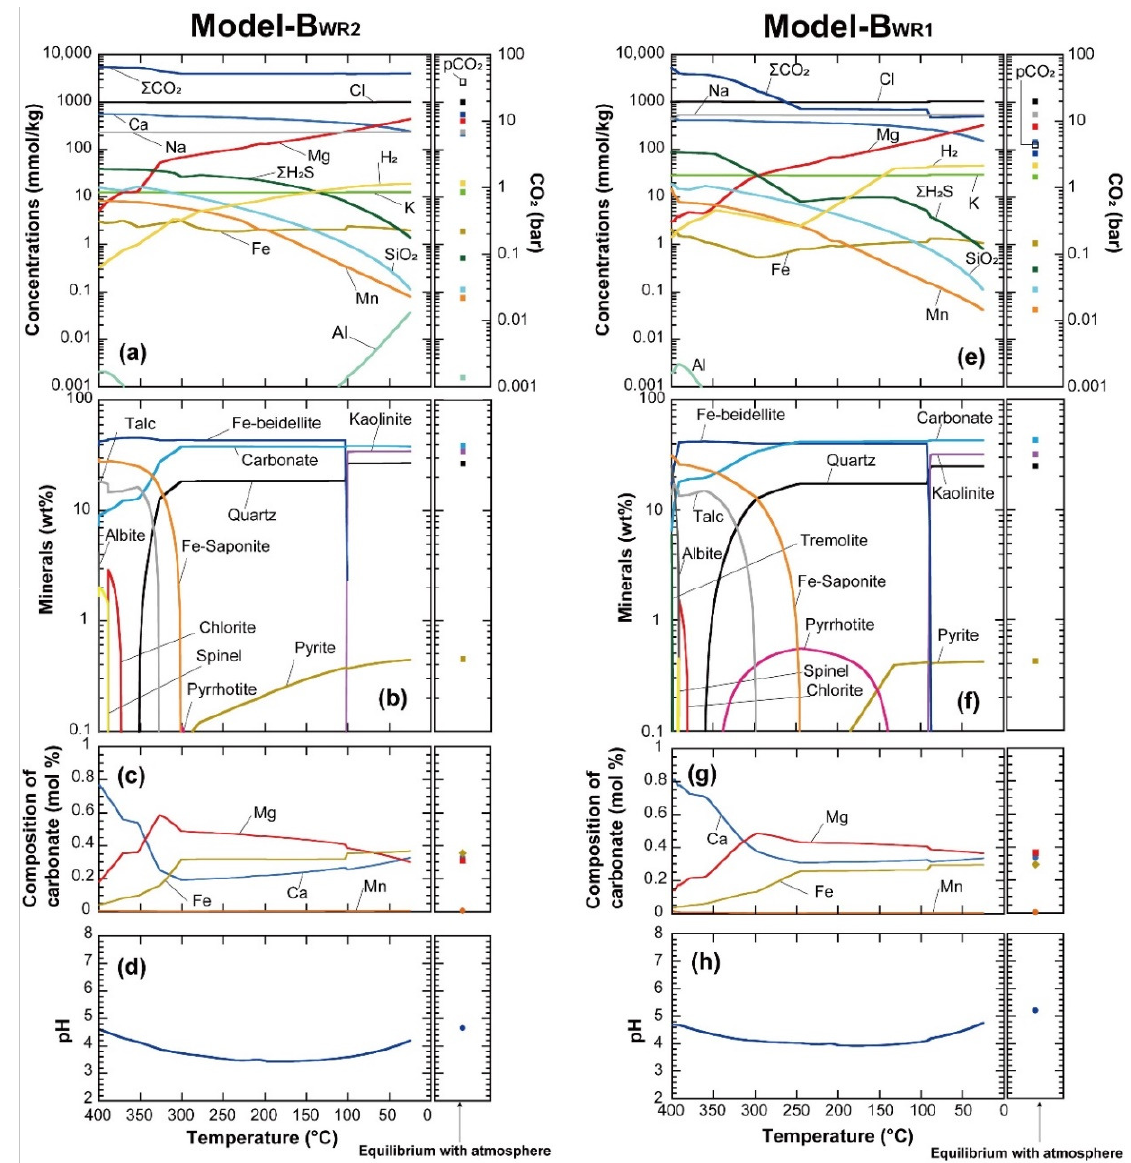
Figure 5. Predicted fluid composition, mineral abundance, and carbonate composition values for Model-B WR2 ( a – d ) and Model-B WR1 ( e – h ) as functions of temperature. In each panel, the results of the re-equilibration simulation for the gas phase, solution, and rock at 25 °C are shown on the right.